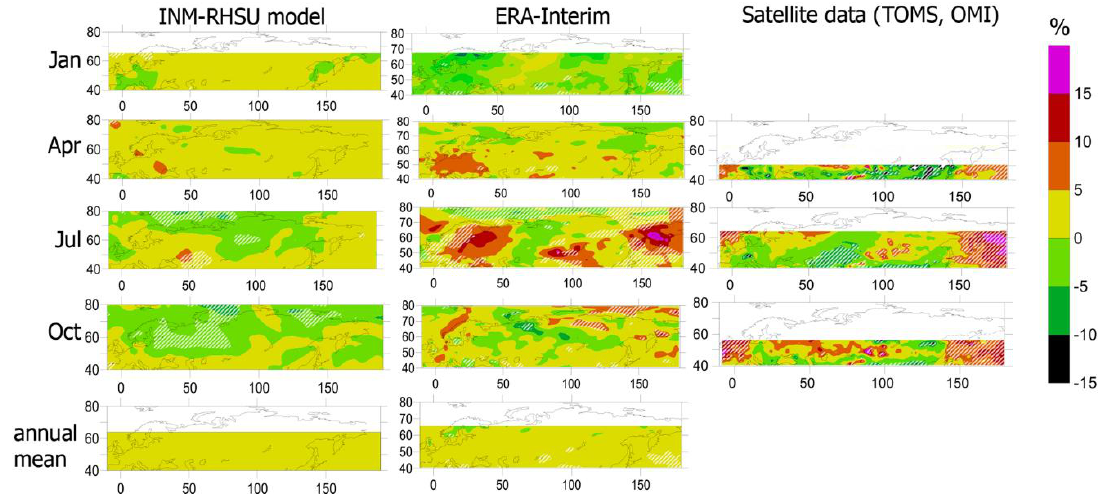
Figure 12. Seasonal and annual differences in Eery anomalies between the 2000–2015 and 1979–1999 periods due to combined effects of changes in total ozone column and cloudiness according to the INM-RSHU CCM model, the ERA-Interim dataset, and Eery retrievals from the TOMS/OMI satellite dataset with the additional Macv2 aerosol correction. Statistically significant difference at 95% are shown by hatching. Note, that we do not present UV retrievals from the TOMS/OMI dataset for January and for annual mean due to the problems in UV retrievals in conditions with high surface snow/ice albedo. X-axis—is longitude, Y-axis—is latitude.